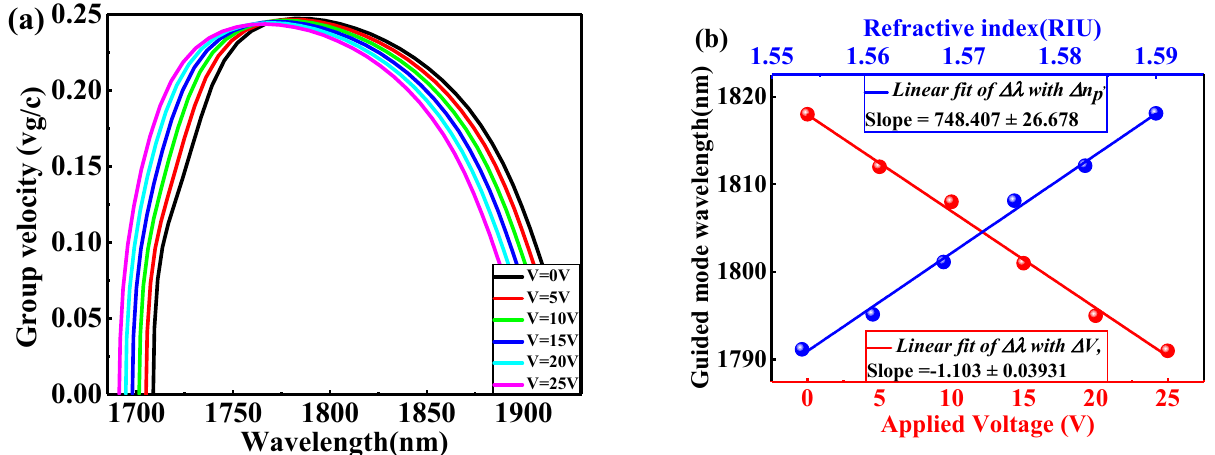
Figure 6. ( a ) The variation of v g / c with the wavelength due to different applied modulation voltages from 0 V to 25 V with an increment of ∆ V = 5 V based on filling the air gaps (triangles and holes) with the nonlinear optical (NLO) polymer; ( b ) the selected guided mode wavelengths corresponding to each value of V and n p .